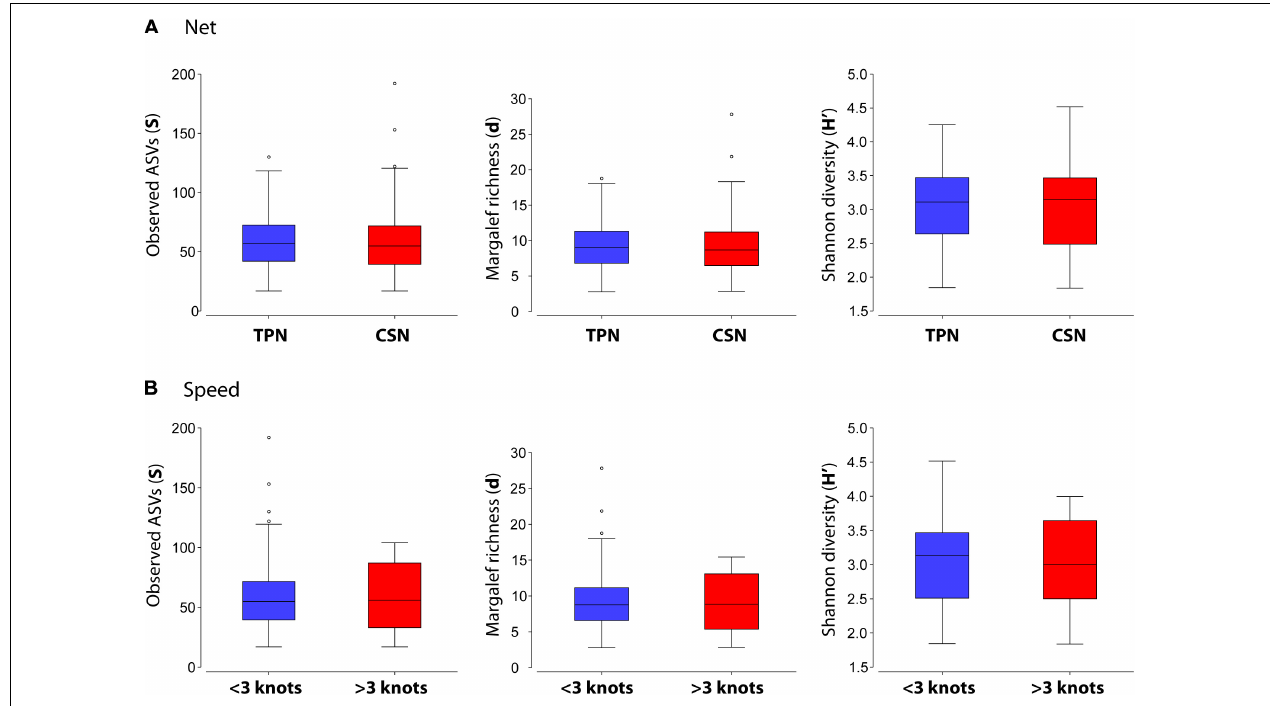
FIGURE 3 | Boxplots comparing diversity indices (Observed ASVs, Margalef richness, and Shannon diversity) obtained with the New Zealand case study dataset for (A) the factors “net” (TPN, Traditional Plankton Net; CSN, Cruising Speed Net), and (B) “speed” (approximately 2/ < 3 knots versus approximately 5/ > 3 knots). TABLE 2 | (A) Pairwise tests for each calculated diversity index (Observed ASVs, Margalef richness, and Shannon diversity) for factors “net” and “speed.” (B) Permutational multivariate analysis of variance (PERMANOVA) based on Bray Curtis similarities for the “net” and “speed” factors. A) Pairwise tests B)